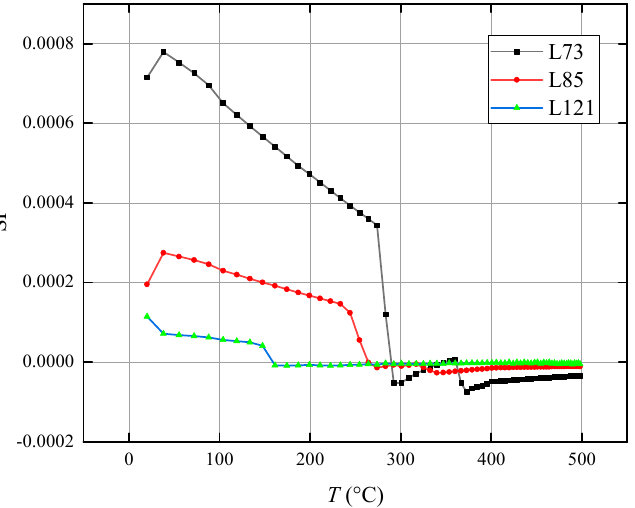
Figure 7. Sensitivity coefficient of member L136 under different fire conditions.